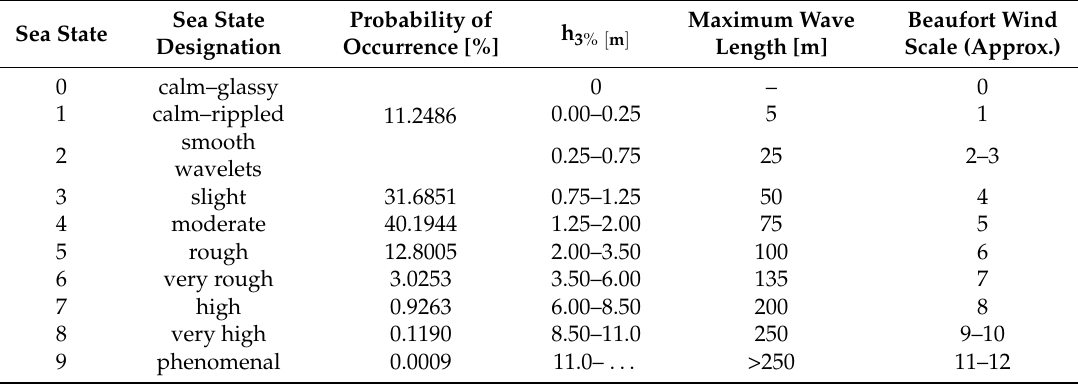
Table 1. Summary of selected parameters of waves depending on the sea state and the Beaufort wind